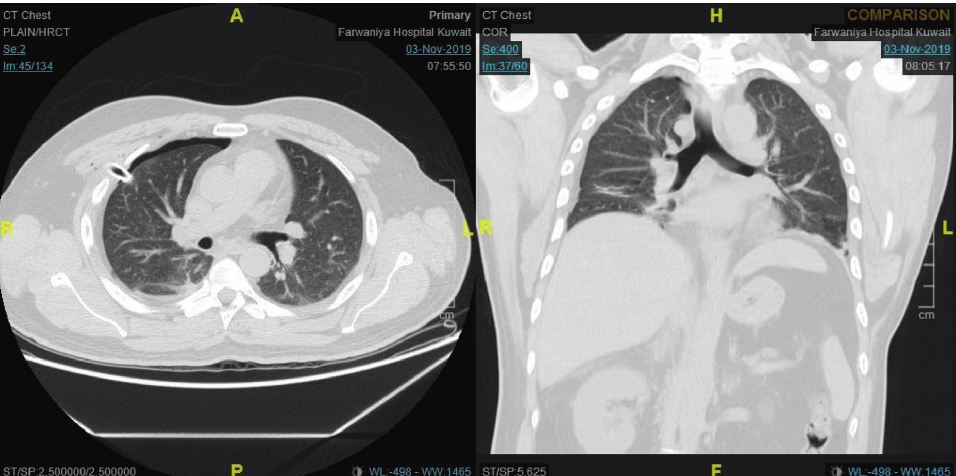
Figure 6: Postoperative computed tomography (CT) scan showing minimal right-side residual pneumothorax and the intercostal tube in place.